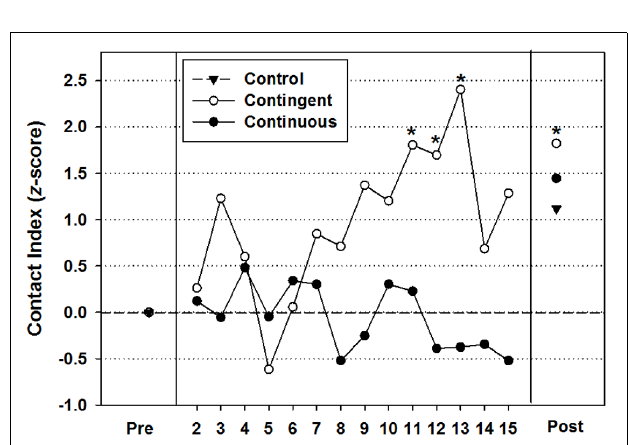
FIGURE 3 | Mean visually attended contact indices ( z -scores) for each group by day. The dashed line at zero indicates no preference for visually attended or non-visually attended contacts. Points with an asterisk are index scores that are greater than z > 1.65, indicating performance level with a 90%